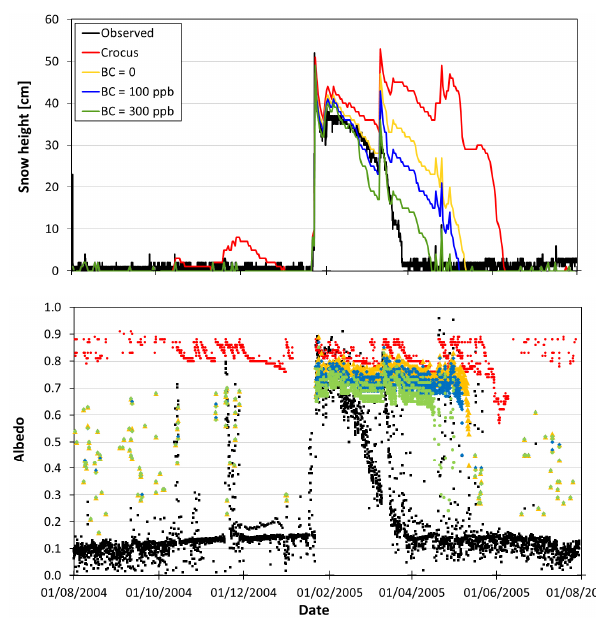
Figure 3. Comparison of observed (black) and simulated snowpack heights (top) and albedo (bottom) at NCO-P for the winter season 2004/2005. Simulations were performed with the standard crocus model (red) and with the upgraded model including radiative trans- fer with constant BC concentrations of 0 (yellow), 100 (blue), and 300ppb (green). Snowpack heights simulated with the upgraded model are indistinguishable for the different BC concentrations un- til late January and after